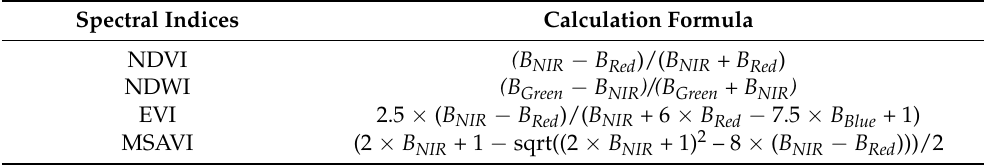
Table 2. The spectral indices used in the